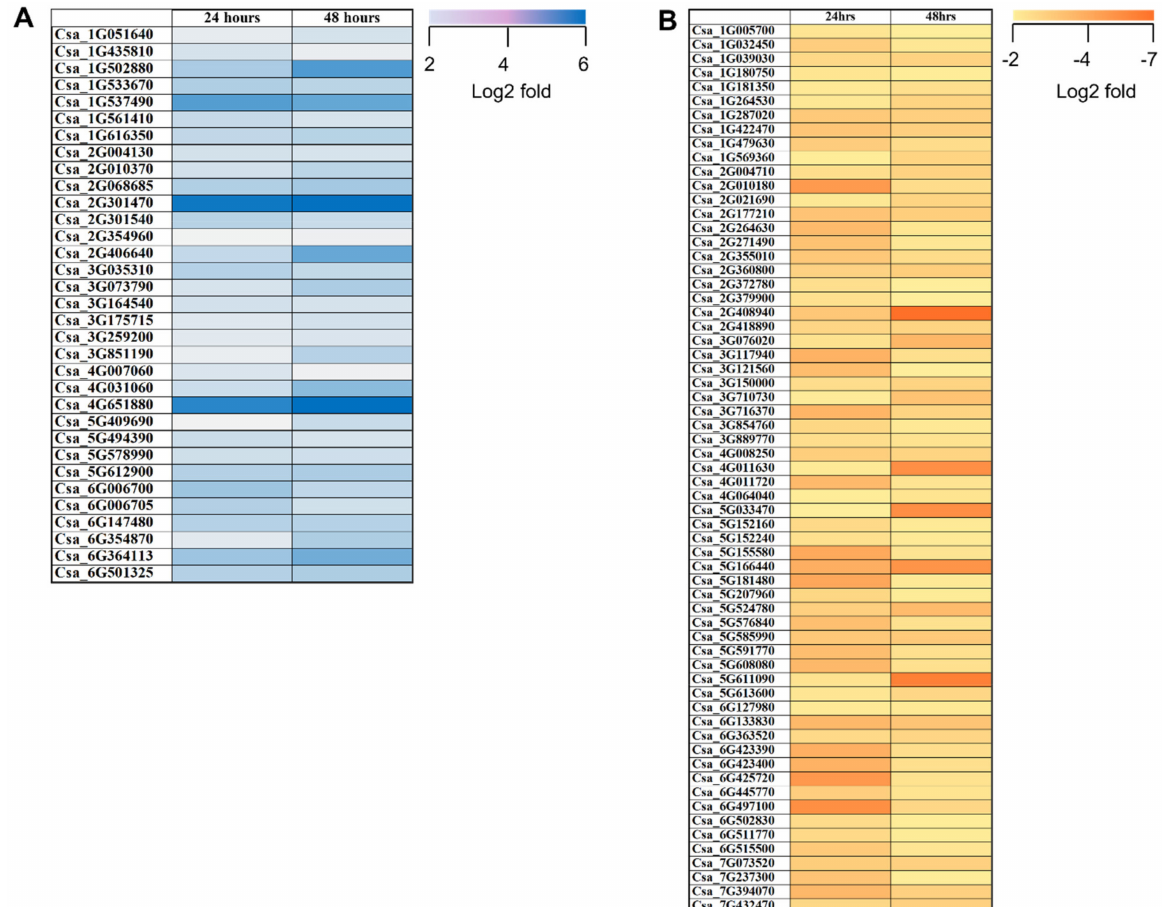
Figure 3. Heat map showing transcription profiles of cucumber roots treated with the biocontrol agent Bacillus subtilis MBI600 at two time points (24 and 48 h post-application); ( A ) up-regulated and ( B ) down-regulated genes. Data were normalized with cucumber roots at 0 h post-application (adjusted p -value < 0.05, absolute log2 fold change > 2). Blue and yellow colors represent up- or down-regulated genes,